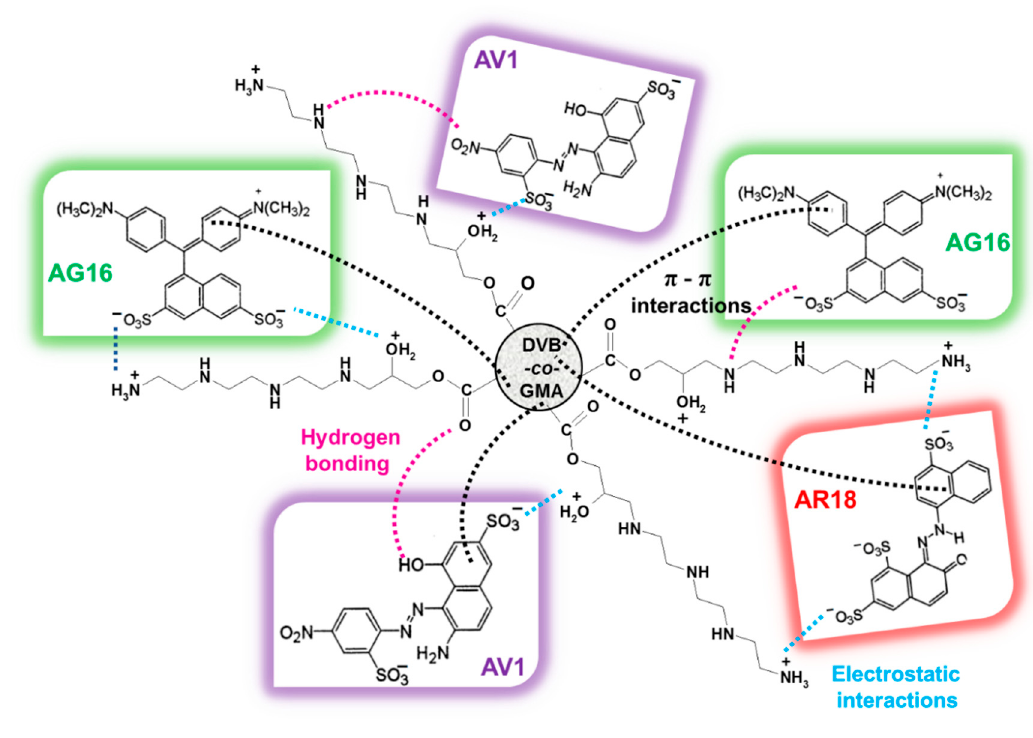
Figure 6. Suggested mechanism of dye interactions with DVB- co -GMA-TETA in aqueous solution.